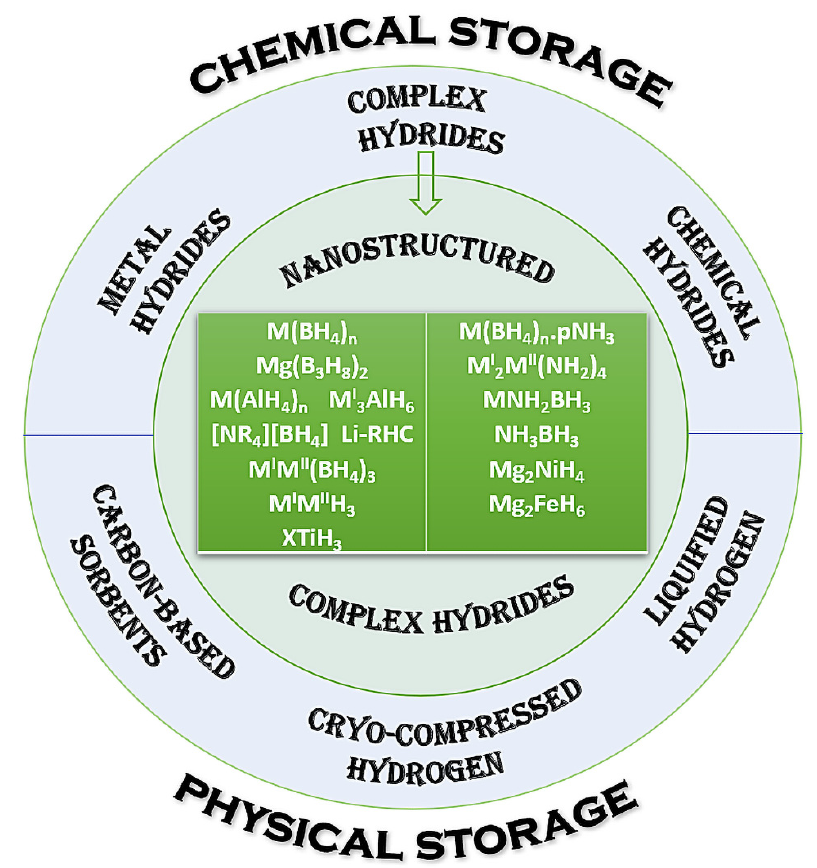
Figure 1. Nanostructuring technique and smart synergies are at the heart of physical and chemical properties improvements in complex hydride materials for solid-state hydrogen storage.